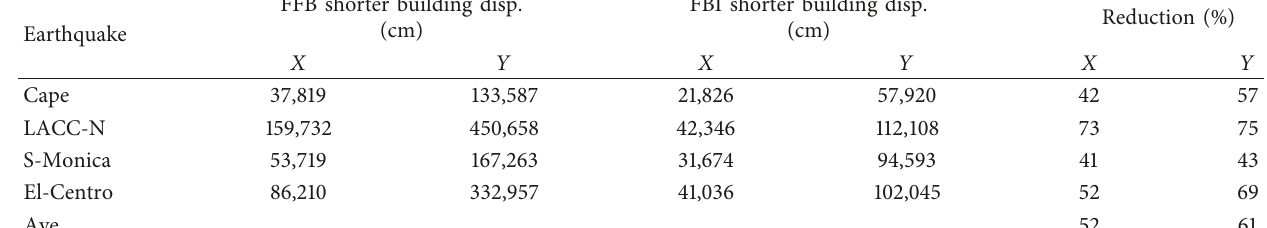
Table 7: Absolute base moment (kN · m) of the adjacent buildings under applied earthquakes. FFB shorter building disp. (cm) Earthquake